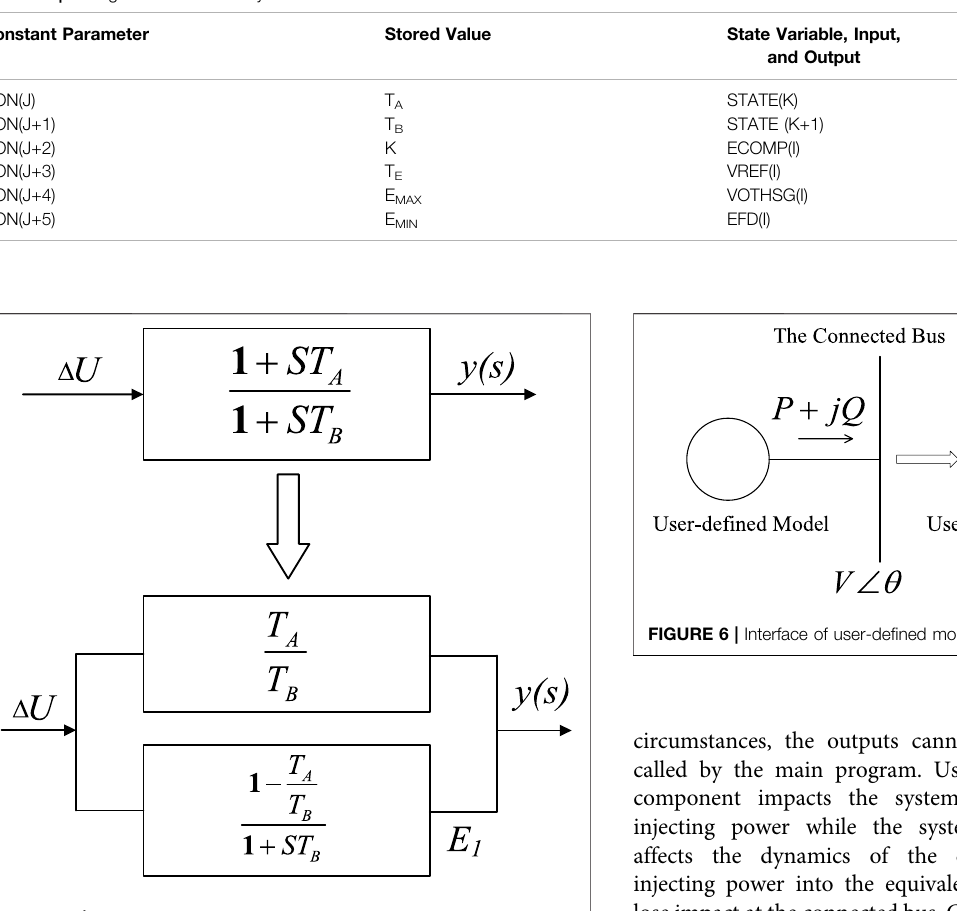
FIGURE 5 | Decomposition of lead-lag control block.